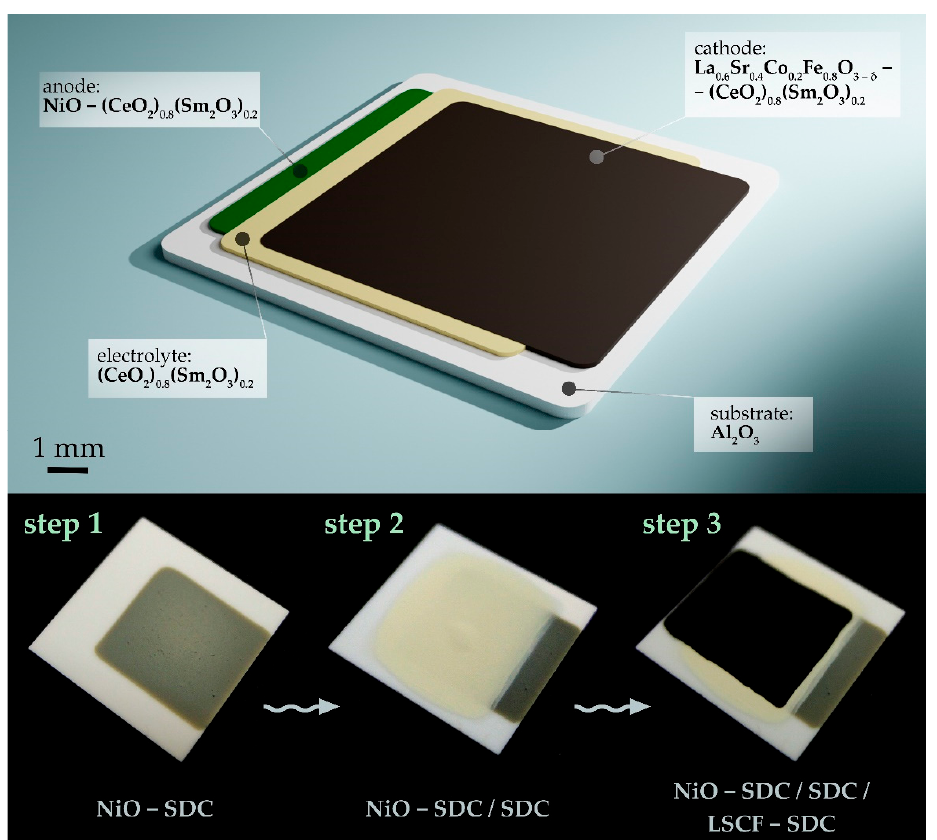
Figure 2. Scheme of the (NiO-SDC)/SDC/(LSCF-SDC) three-layer structure formed ( top ) and the appearance of the functional layers ( bottom ) sequentially deposited on the Al 2 O 3 substrate surface (left—composite anode layer, middle—electrolyte layer on the anode surface, right—composite cathode layer on the electrolyte surface).